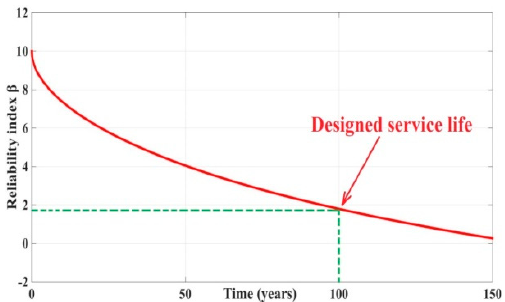
Figure 17. Reliability index calculated by the Monte-Carlo simulation for the platform concrete.